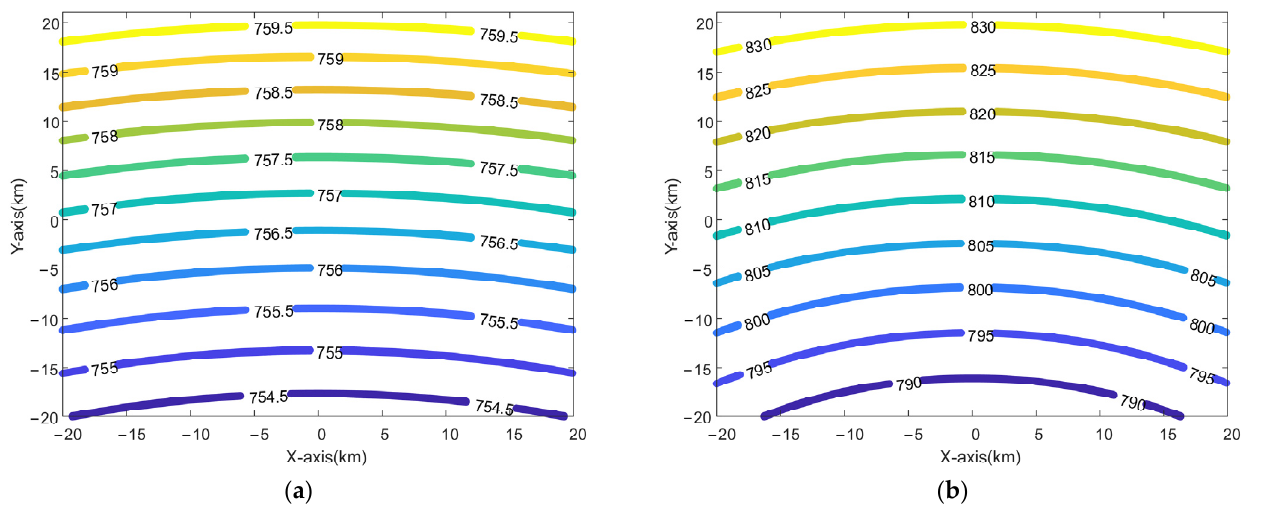
( b ) Contour formed by 0 bf R of each point in the scene.